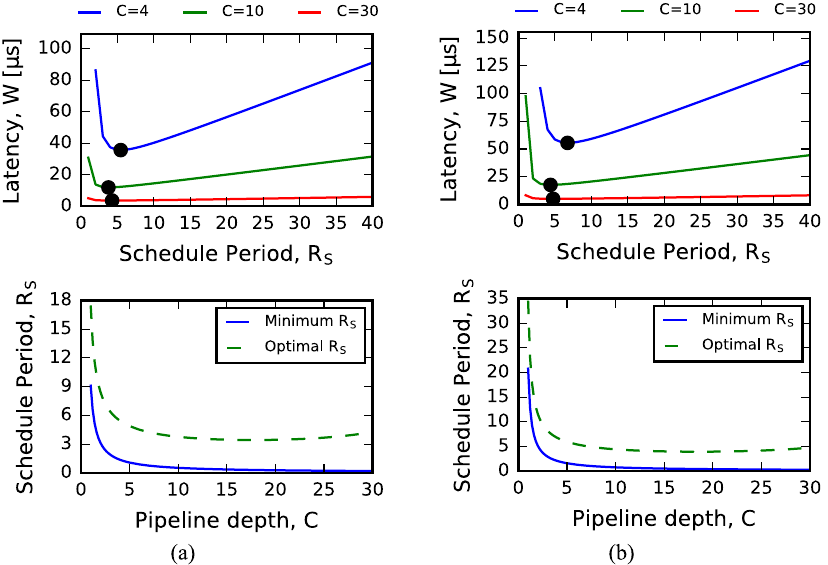
Figure 19. Latency prediction (top) and optimization (bottom) plots for the SHA-2 application. The parameters used are N = 60, S = 10 C , and λ = 30 Kelems . In the latency plots, the optimal R S s for minimum latency is indicated by a dot. ( a ) SHA-256 ( b ) SHA-512. In the optimization plots, there are two curves. The solid blue curve shows the minimum R S needed to service a given pipeline depth (that is, ρ < 1). The dashed green curve shows the optimal R S that minimizes latency at the given pipeline